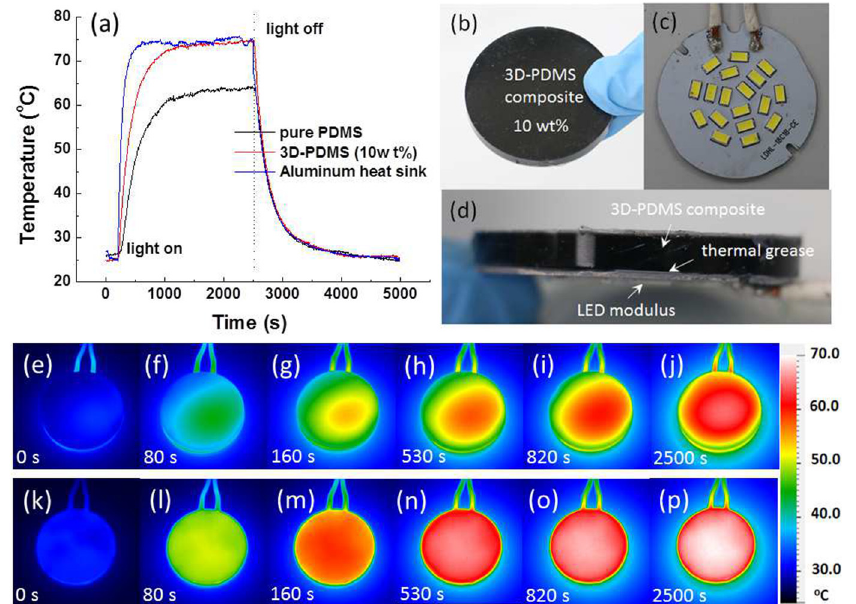
Figure 16. ( a ) Temperature–time profiles of LED modules incorporating Al, pure PDMS, and 3D- PDMS composites as heat sinks. ( b ) Photograph of the 3D-PDMS composite and ( c ) LED modulus. ( d ) Cross sectional image of an LED modulus featuring a polymeric heat sink. ( e – p ) Thermal imaging photographs of LED modules featuring ( e – j ) pure PDMS and ( k – p ) 3D-MWCNT/PDMS composite (10.0 wt%) as heat sinks, taken after various heating times. Reprinted with permission from reference [250] . Copyright (2008) Elsevier.